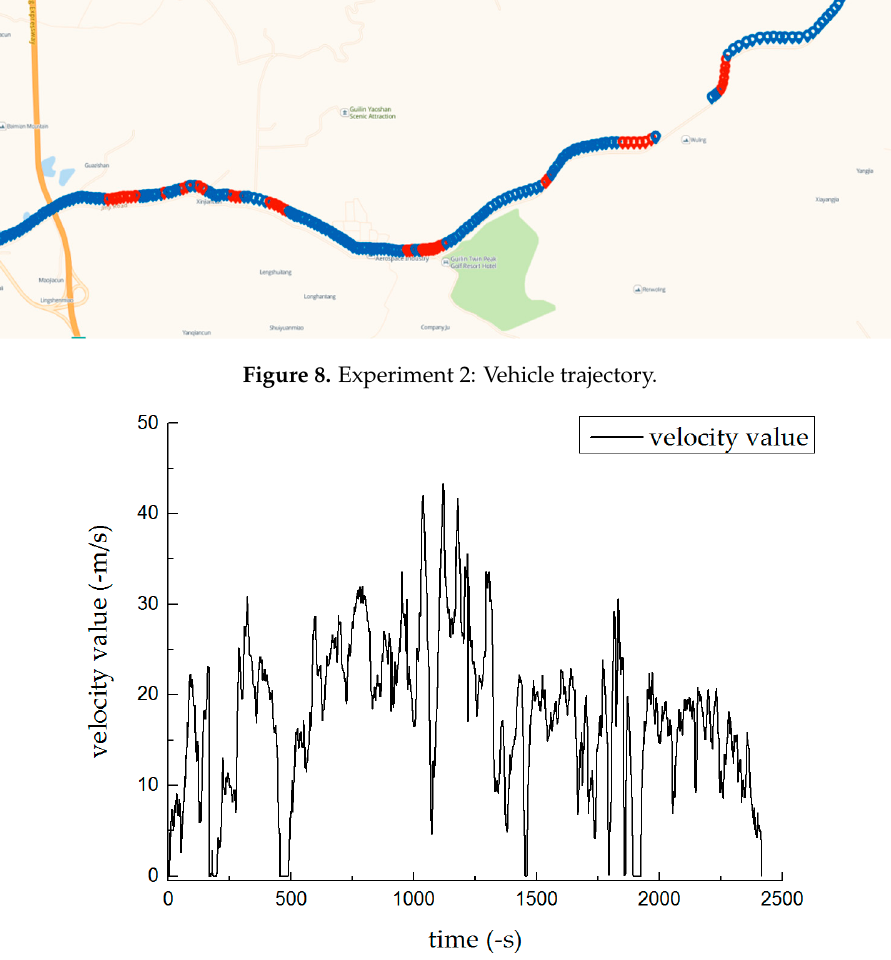
Figure 9. Experiment 2: Vehicle Speed.